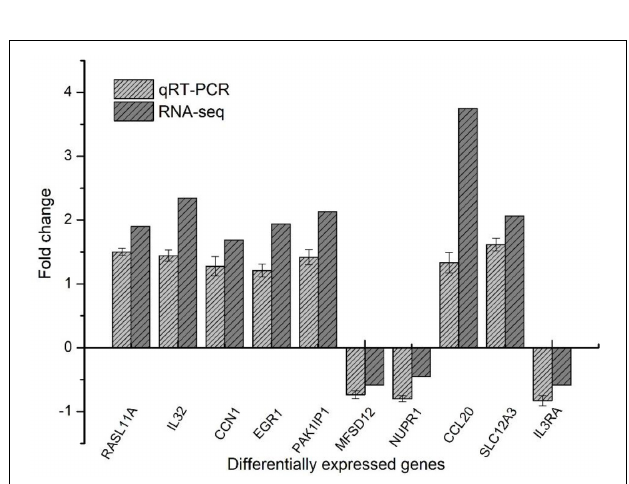
FIGURE 9 | Diagram of protein–protein interactions predicted by string.